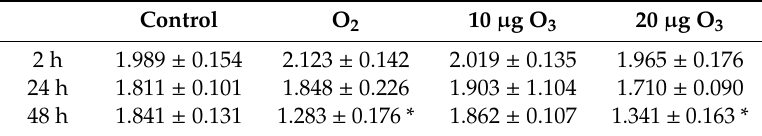
Table 3. Mitochondrial inner / outer membrane ratio (mean ± SE) according to treatment and incubation time post-treatment. Asterisks indicate statistical di ff erence from control (* p <